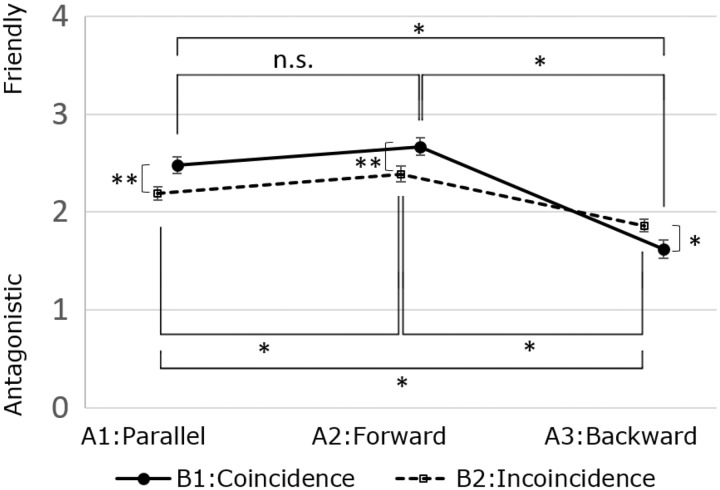
Two-way repeated-measure ANOVA and multiple comparisons using the LSD method for Item 1: friendly–antagonistic atmosphere (**p < .01, *p < .05). Error bars represent standard errors.